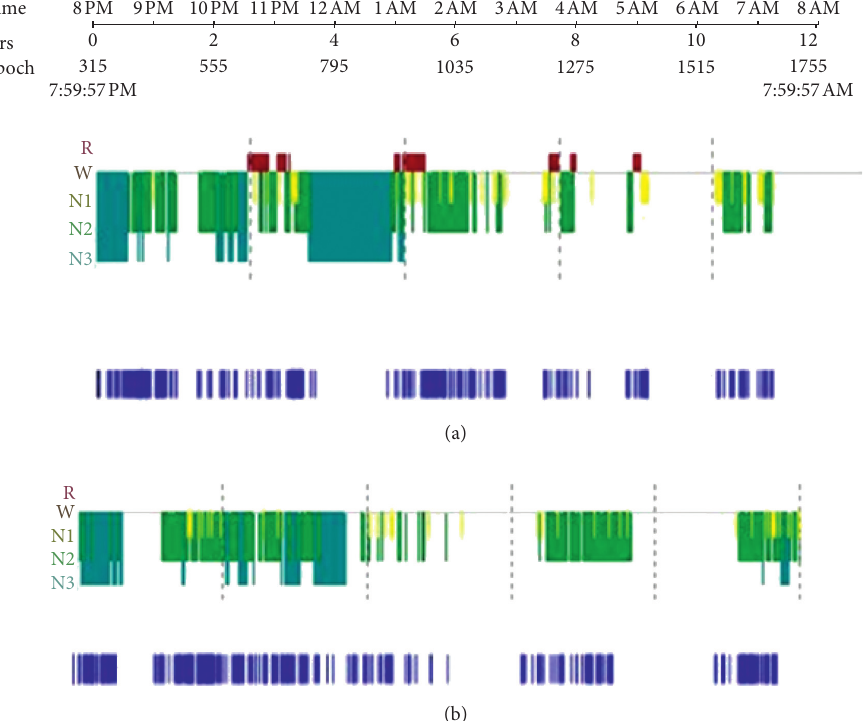
Figure 3: Control versus melatonin subject’ hypnogram. R, REM stage; N 1– N 3, non-REM stages. Comparison between normal sleep stages in a healthy subject (hypnogram a) and one of the melatonin subjects (hypnogram b) showing absence of REM and non-REM sleep stages and presence of numerous arousals through all stages of